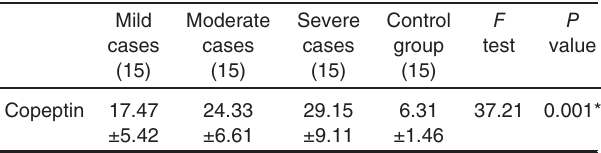
Table 5 Comparison between the studied groups according to copeptin